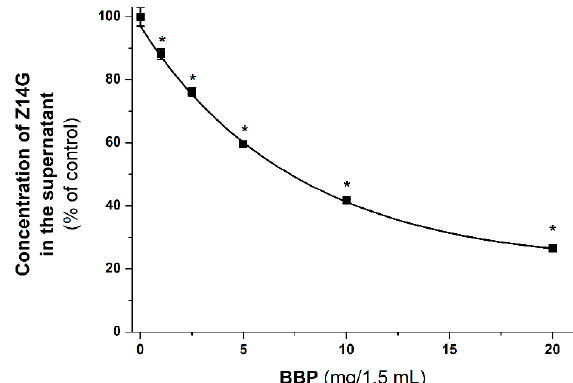
Figure 8. The decrease of Z14G (2 µM in 1.5 mL) content of the supernatant after 30 min incubation with increasing amounts of BBP (0.0, 1.0, 2.5, 5.0, 10.0, and 20.0 mg/1.5 mL) in 0.05 M sodium acetate buffer (pH 5.0; 25 °C; * p < 0.01).